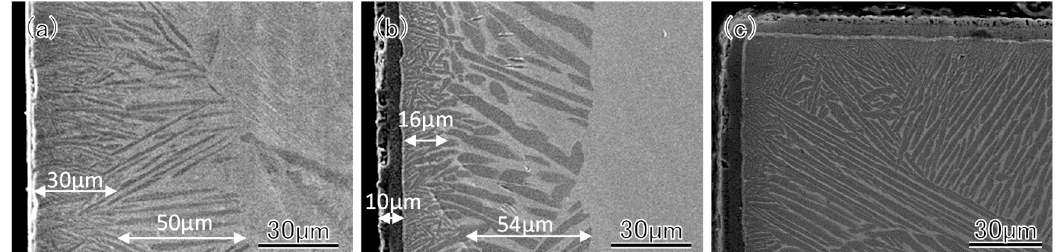
Figure 1. Cross-sectional SEM microstructure after the gas nitriding and quenching process (GNQP). ( a ) Edge area at 1023 K. ( b ) Edge area at 1223 K. ( c ) Corner area at 1223 K.